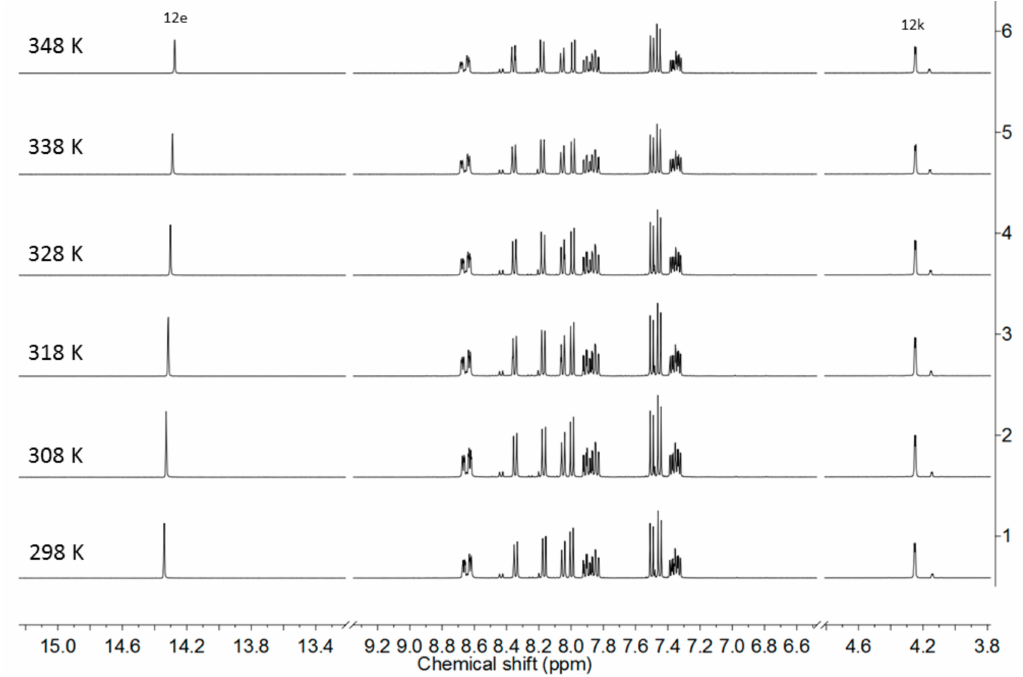
Figure 2. High shift region of the variable temperature (VT) 1 H-NMR spectra of Compound 3 in CD 3